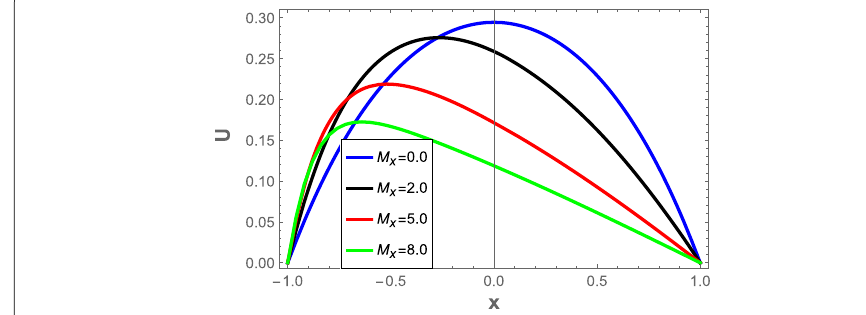
Figure 4 Various Hartmann number values are used to build a velocity profile